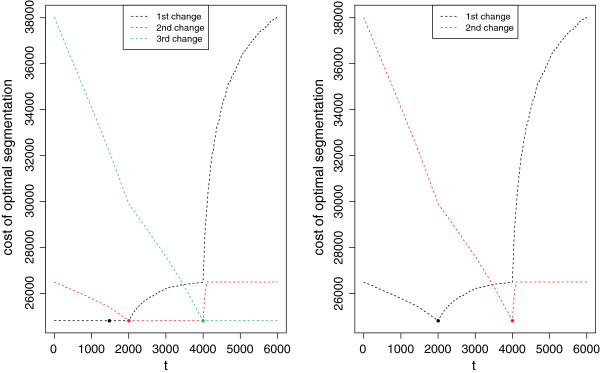
Cost of optimal segmentation in 4 and 3 segments. Cost of optimal segmentation depending on the location of the jth change-point when the number of segments is 4 (Left) and 3 (Right) and the signal was simulated with 3 segments. Illustration of the output of function BestSegmentation.